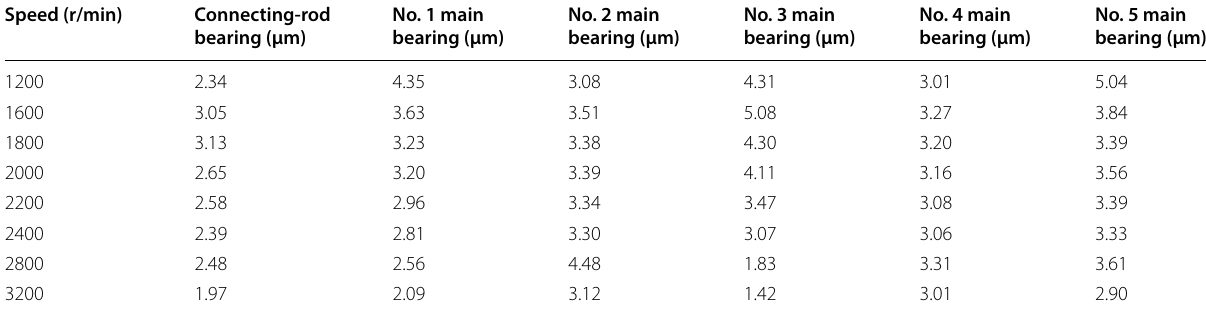
Table 5 Minimum film thicknesses of connecting‑rod bearing and main bearings at full load and different speed Speed (r/min) Connecting-rod bearing